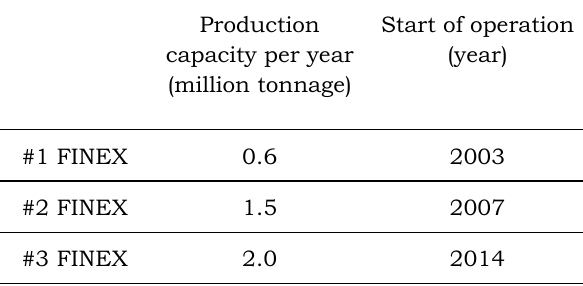
Table 2. Production capacity of POSCO FINEX